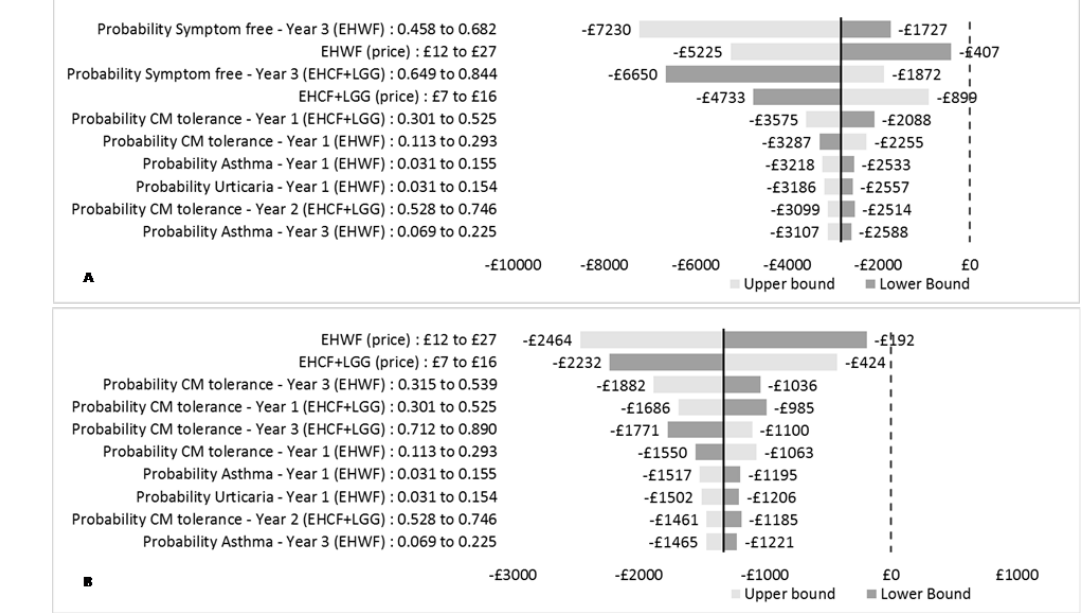
A: Tornado diagram for the probability of being symptom free at 3 years; B: Tornado diagram for the probability of being tolerant to cow’s milk at 3 years. Abbreviations: CM, cow’s milk; EHCF+LGG, extensively hydrolysed casein formula containing Lactobacillus rhamnosus Gorbach Goldin (EHCF+LGG); EHWF, extensively hydrolysed whey formula. The tornado diagram represents how varying inputs between specific ranges influences the outcomes. The bold vertical line represents the base case results. The horizontal bars are stacked in order of decreasing width, with more influential inputs at the top. Horizontal lines crossing the vertical dashed line would represent a change in the conclusions of the model caused by varying a single